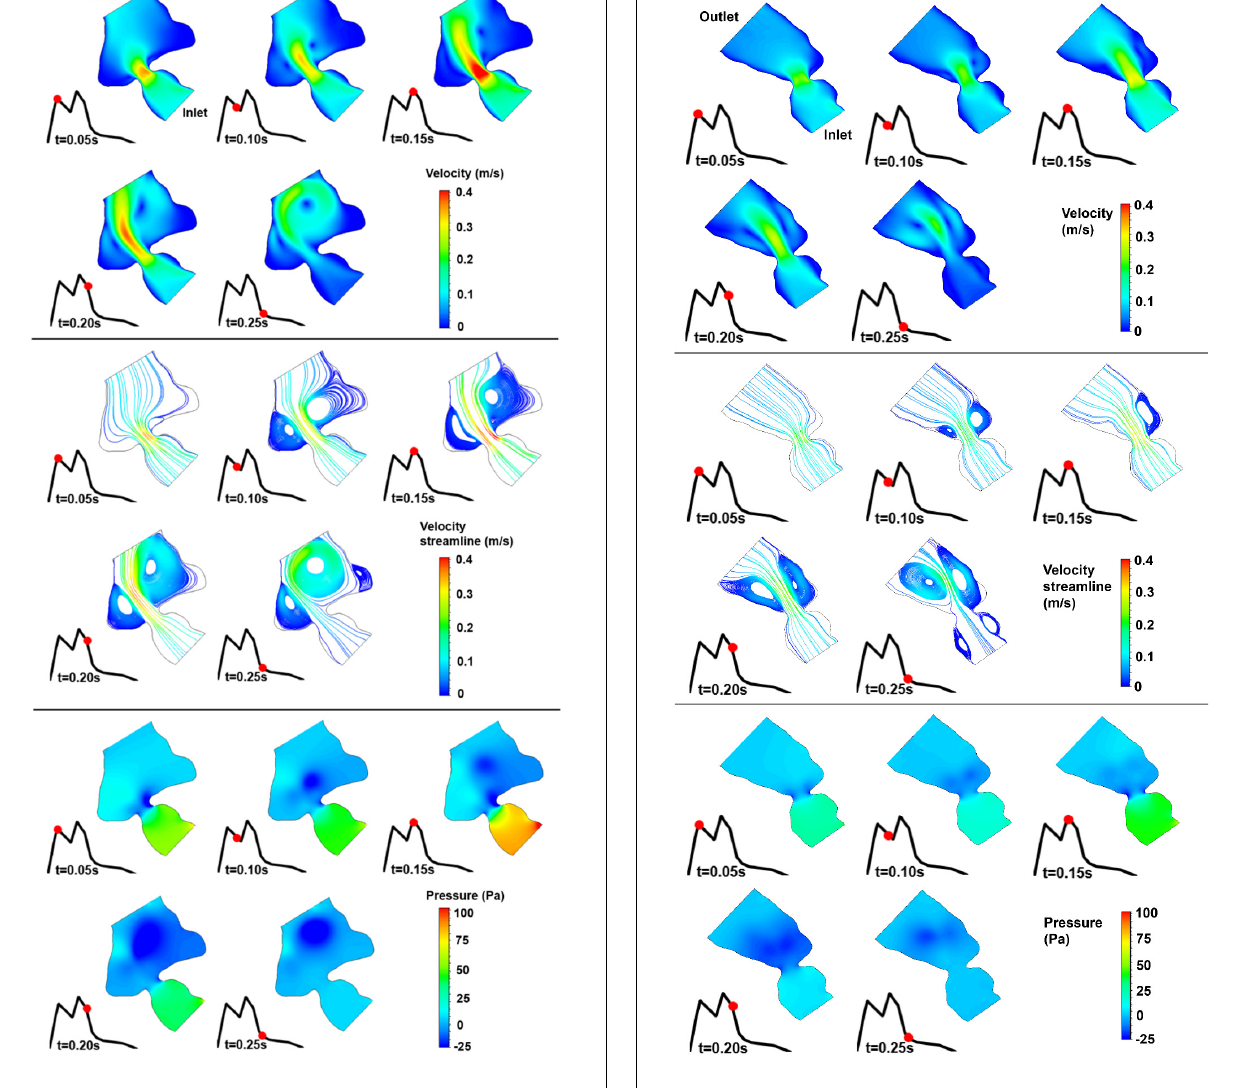
FIGURE 8 | Velocity magnitude, velocity streamline, and pressure contours for the control 1 heart at week 16. The instant in the cardiac cycle is shown near the plots.